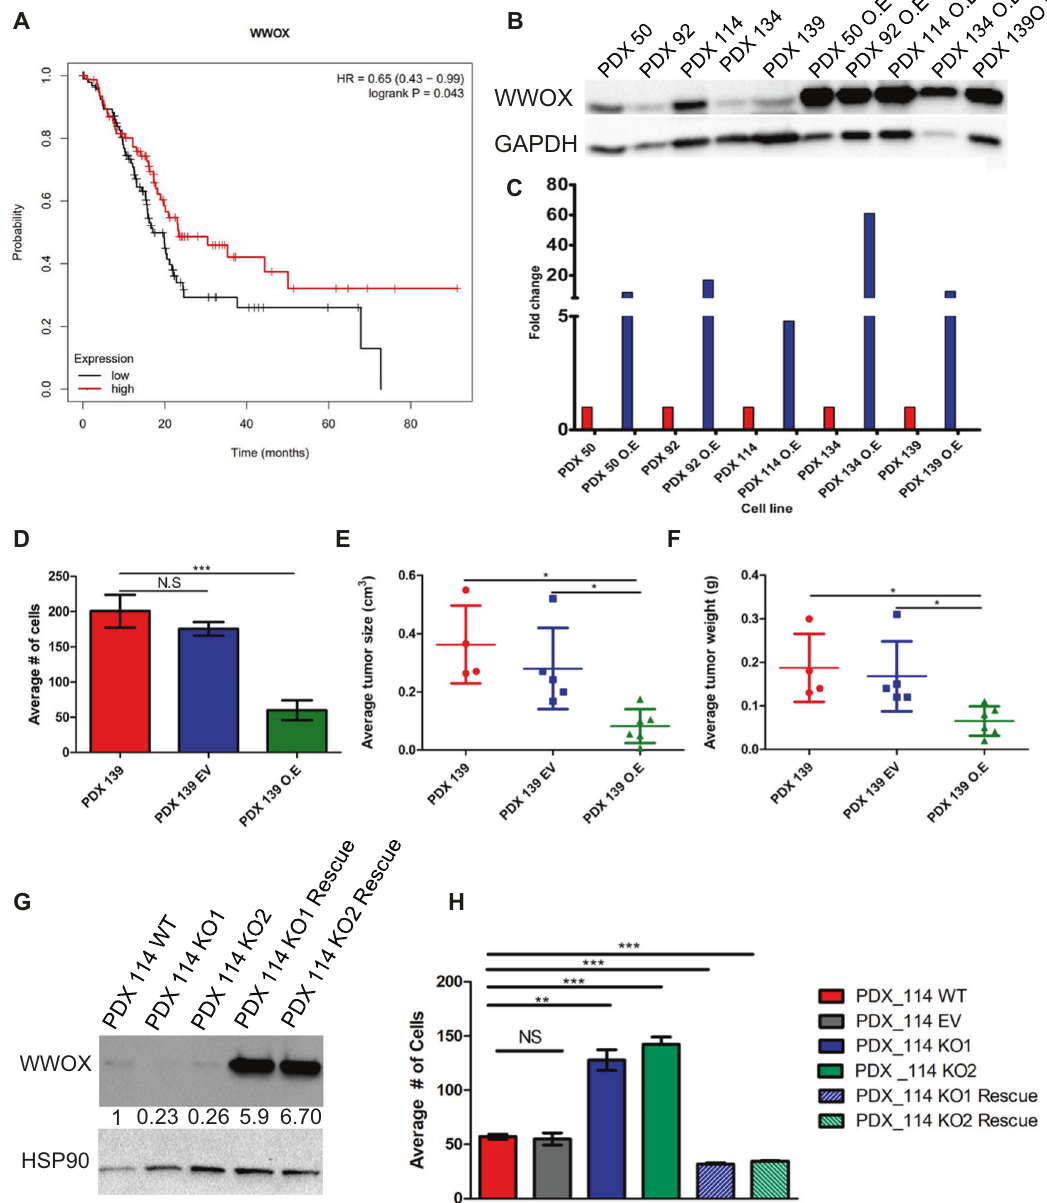
Fig. 6 WWOX loss in human PDAC patients and PDX models. A Low expression of WWOX correlates with worse overall survival of PDAC patients as assessed using KM plotter dataset. The red line indicates high expression, while the black line low expression of WWOX. B Immunoblotting of WWOX in PDXs and PDXs-WWOX overexpression. C Quanti fi cation of WWOX expression from B . D Quanti fi cation of colony formation of PDX-139, EV, and WWOX O.E, respectively. E Average tumor size of PDX-139 WT ( n = 4), PDX-139 EV ( n = 5), and PDX-139 WWOX O.E ( n = 6). F Average tumor weight of PDX-139 WT ( n = 4), PDX-139 EV ( n = 5), and PDX-139 WWOX O.E ( n = 6). G Immunoblotting of WWOX in PDX114, KO, and KO rescue. H Quanti fi cation of colony formation of PDX114, EV, KO, and KO rescue. NS > 0.05, * P < 0.05, ** P < 0. 001, *** P < 0. 0001. Two-tail unpaired t -test. Quanti fi cation graphs are presenting the means ± SD.